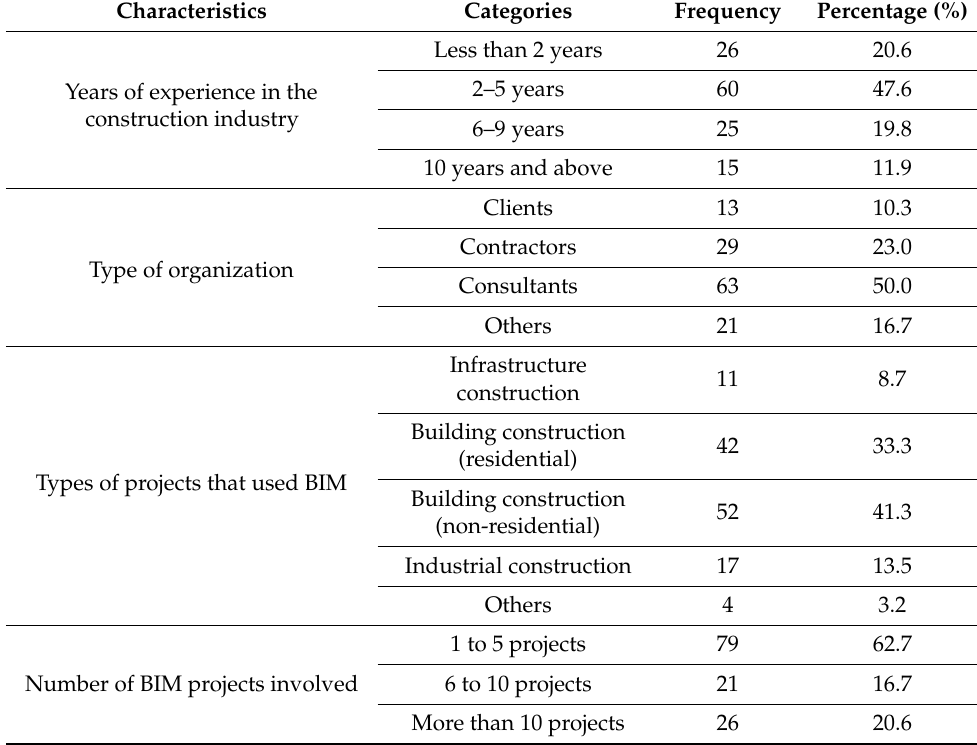
Table 3. Respondent’s